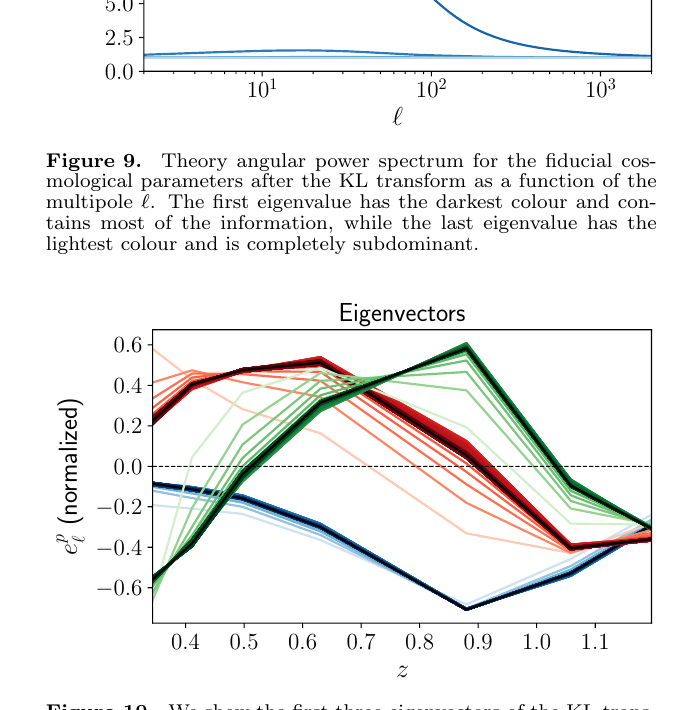
Eq. 9 as a function of redshift. Each colour represents a single eigenvector, while different shades refer to dif- ferent (cid:96) s: lighter colours for low- (cid:96) s and darker ones for high- (cid:96) s. Excluding the first few (cid:96) s (where cosmic